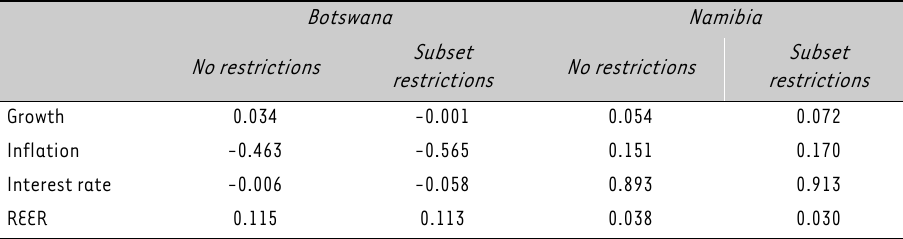
Sum of parameter values